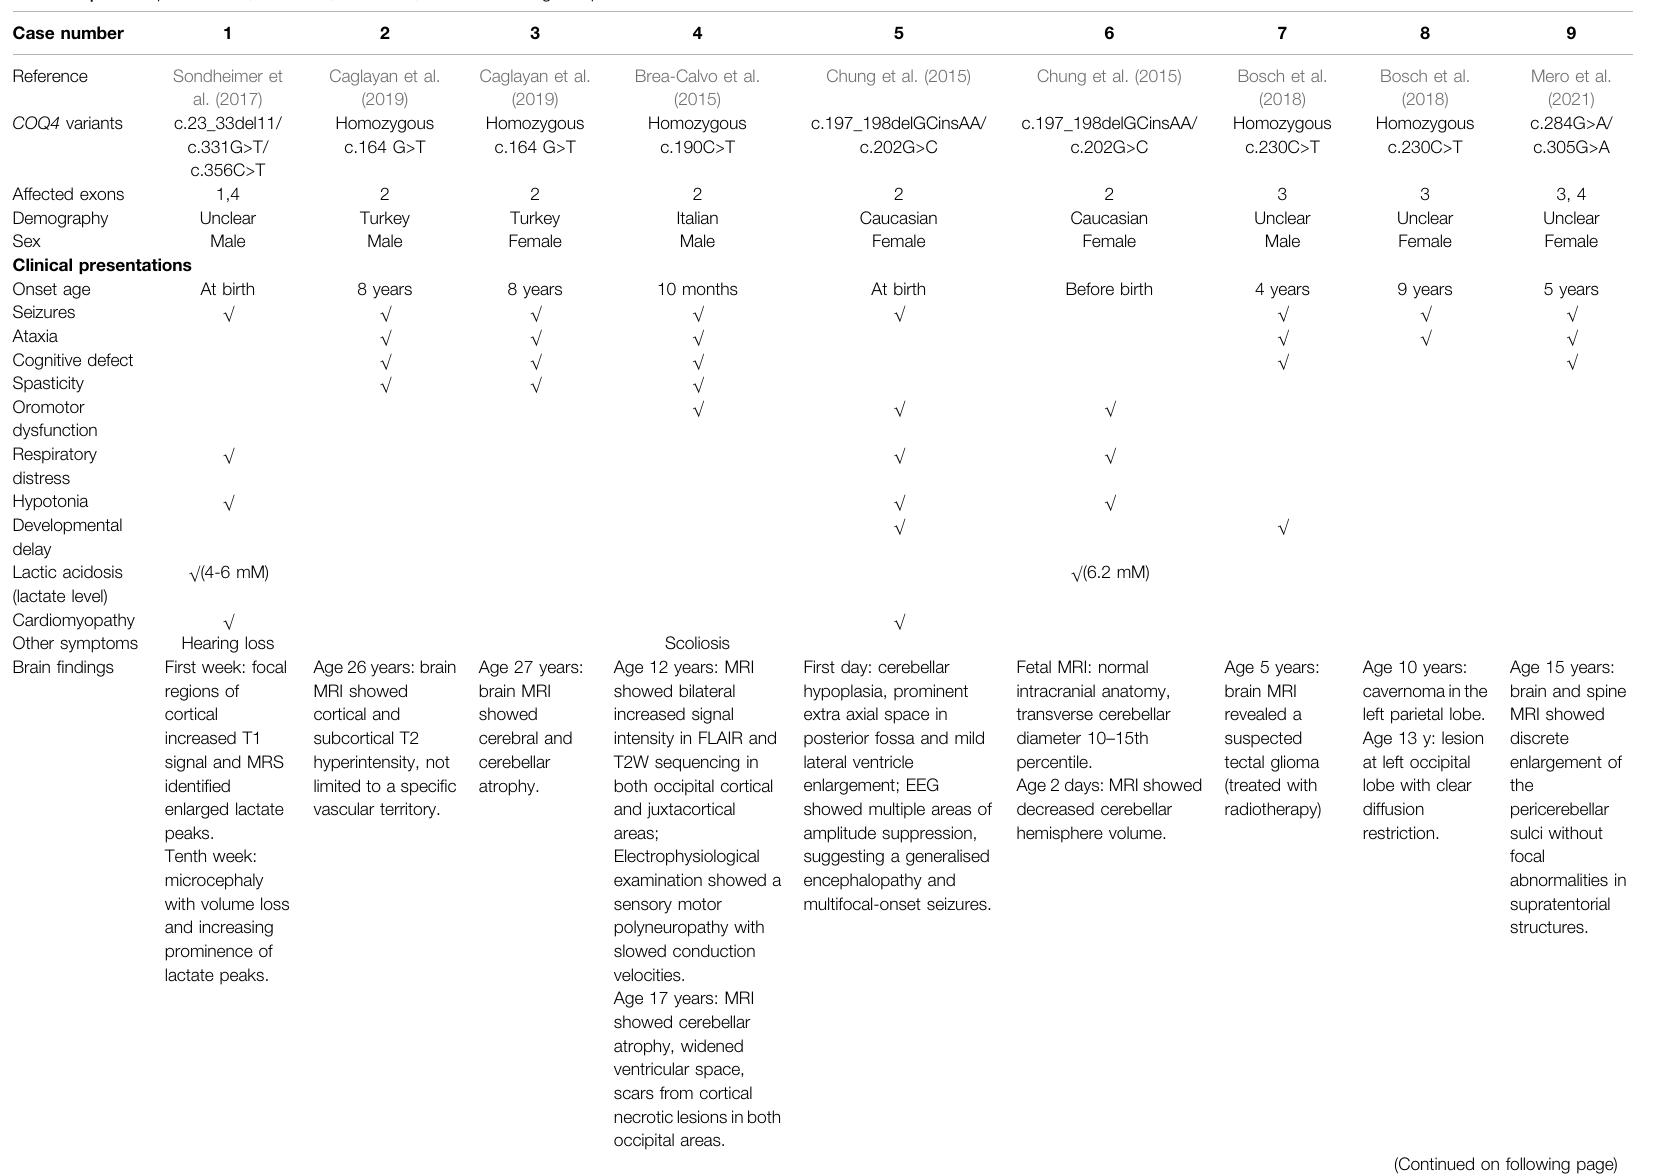
TABLE 1 | Clinical presentation, treatment, outcomes, and brain fi ndings for patients with COQ4 variants in exons